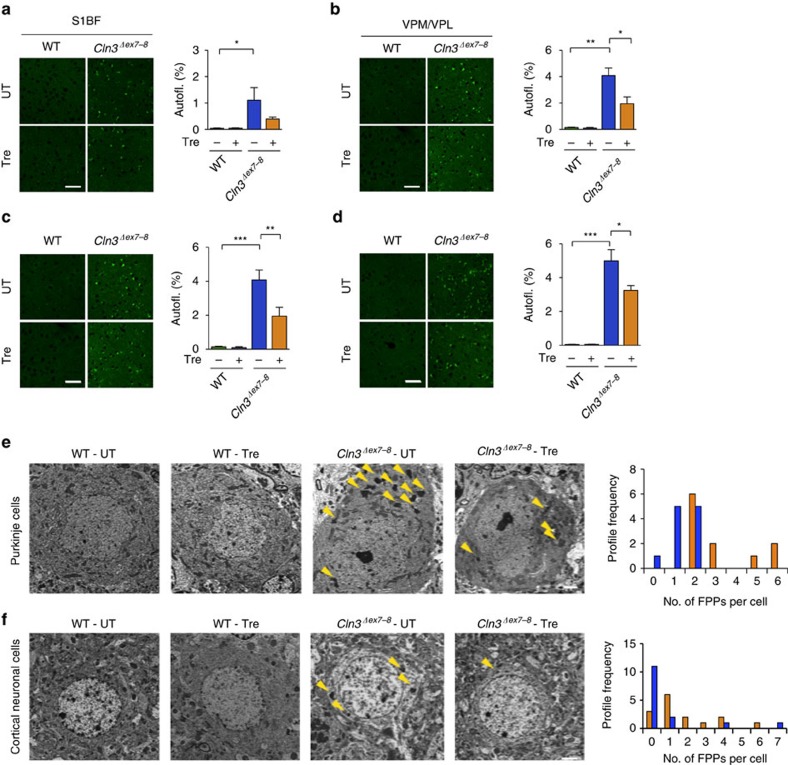
Assessment of storage burden.(a,b) Confocal images and quantification of the storage material in trehalose-treated (Tre) and untreated mice in the primary somatosensory cortex (S1BF; a), and in the interconnected thalamic relay nucleus (VPM/VPL; b) at 7 month of age. Thresholding image analysis revealed higher levels of autofluorescent storage material in the cortex and thalamus of Cln3Δex7-8 mice, which is reduced by trehalose treatment. Scale bar, 50 μm. All groups of mice, n=3 or 4. (c,d) Confocal images and quantification of the amount of storage material in 12-month-old trehalose-treated and control mice in the primary somatosensory cortex (S1BF; c) and in the interconnected thalamic relay nucleus (VPM/VPL; d). Thresholding image analysis revealed higher levels of autofluorescent storage material in the cortex and thalamus of Cln3Δex7-8 mice, which is partially rescued by trehalose treatment. All groups of mice, n=3 or 4. Scale bar, 50 μm (a–d). Data represent means±s.e.m. *P<0.05, **P<0.01, ***P<0.001. (e,f) TEM analysis of untreated (UT) Cln3Δex7-8 mouse brains show marked accumulation of electron-dense cytoplasmic material (yellow arrowheads) in both Purkinje cells (e) and cortical neurons (f). Frequency distribution of FPPs counting revealed a significant reduction of FPPs in trehalose (Tre)-treated mice. n of cells per group of mice=18. Kolmogorov–Smirnov test was applied for frequency analysis. Scale bars, 2 μm.